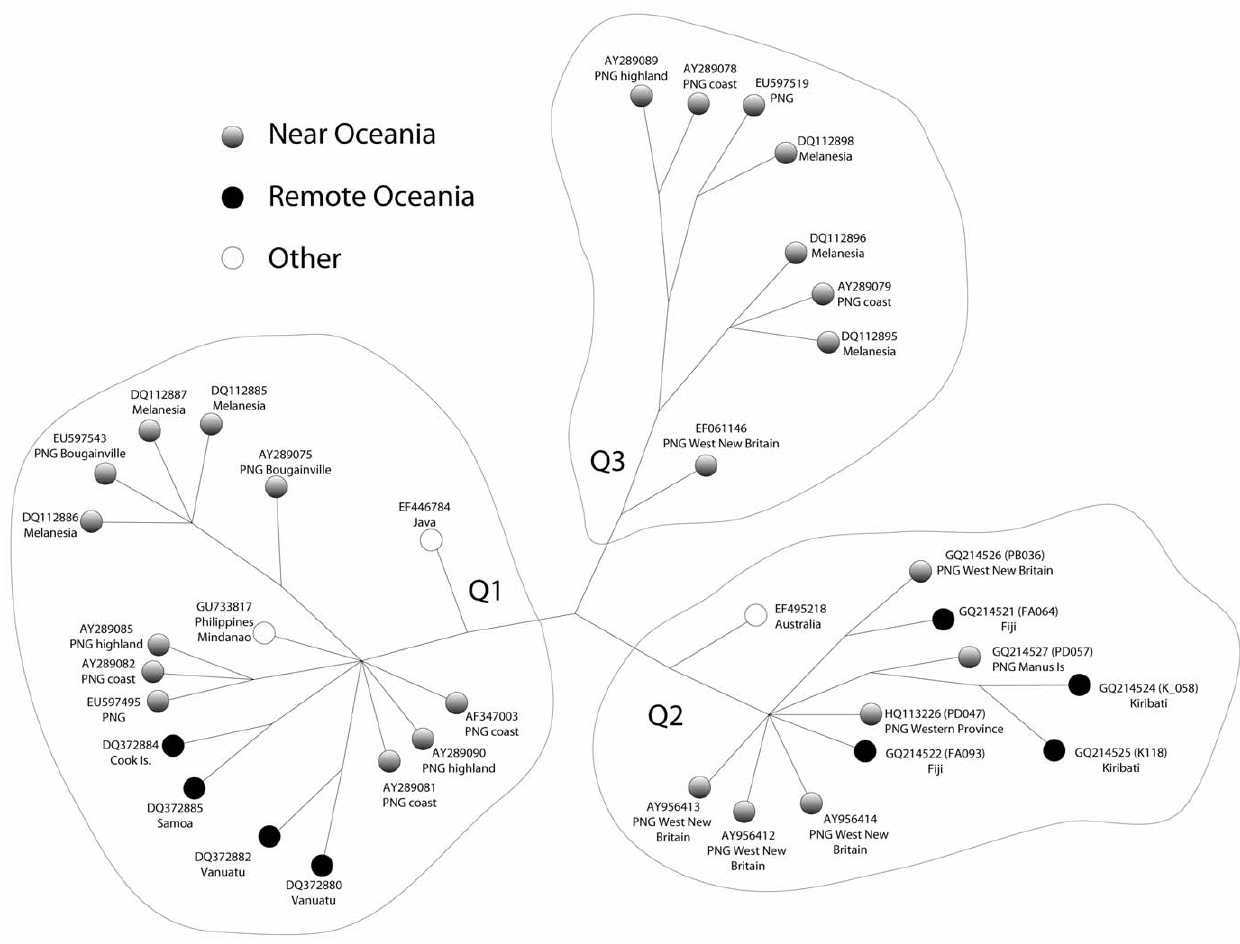
Figure 2. Overview of the Q haplogroup. The dataset has 36 mitochondrial genomes including all eight Q3 sequences, 17 Q1, three Q2 genomes from Friedlaender et al. [28], one from Hudjashov et al. [36], together with the seven additional Q2a genomes reported here. The network has been proved the shortest possible (the minimum number of mutations) by using the techniques in Pierson et al. [40]. Differences in branching between the four equally parsimonious trees occur in the Q3